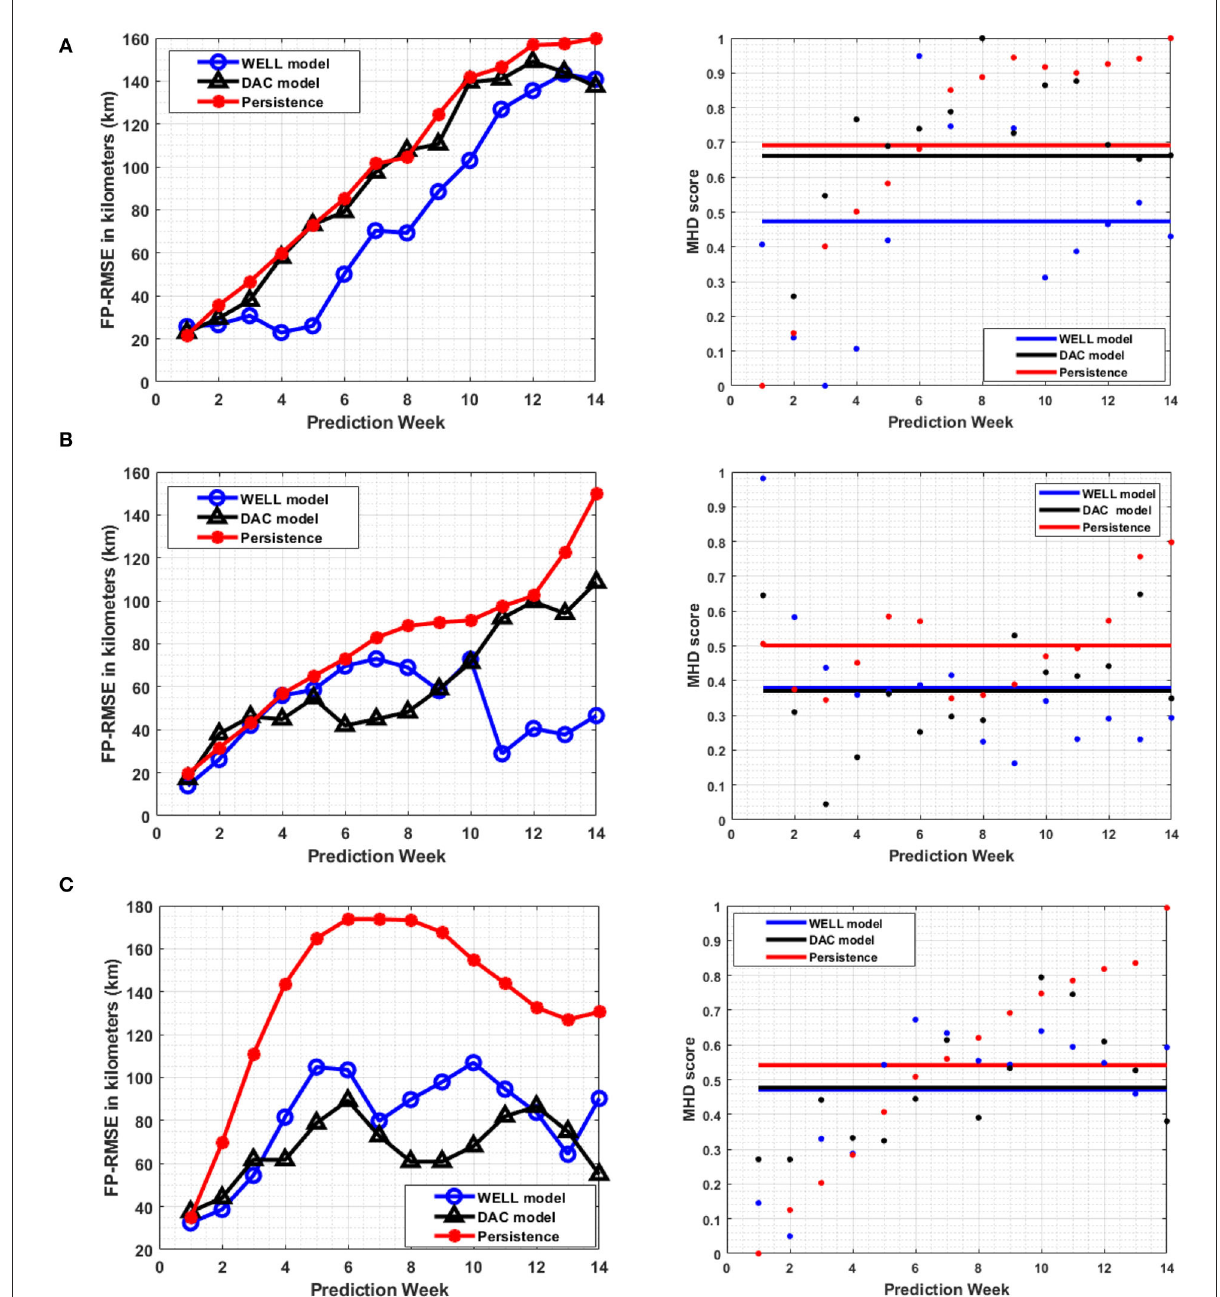
FIGURE11 The average FP RMSE (left column) and the average MHD score (right column) per week for 14-week prediction windows over a four-week sliding window using the 0.45 m contour level of the SSH. (A) Eddy Cameron formation in July 2008. (B) Eddy Darwin formation in December 2008. (C) Loop current leap state in May 2009 (average of 4 weeks). The horizontal lines on the graph in the right column indicate the mean value of the MHD.